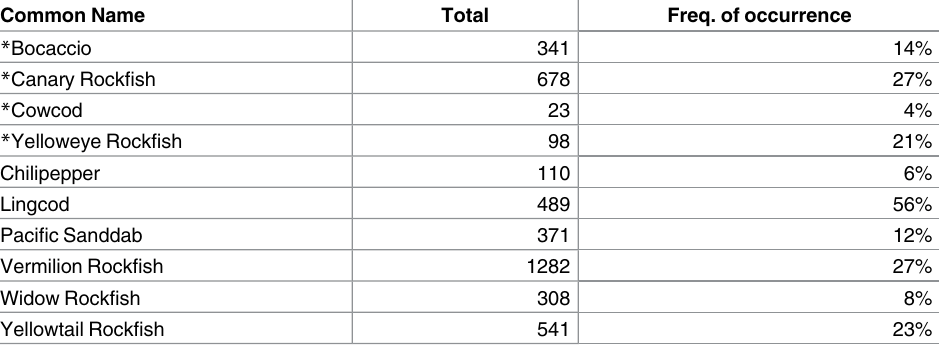
Table 3. Total number of fish observed in video surveysfor ten species of